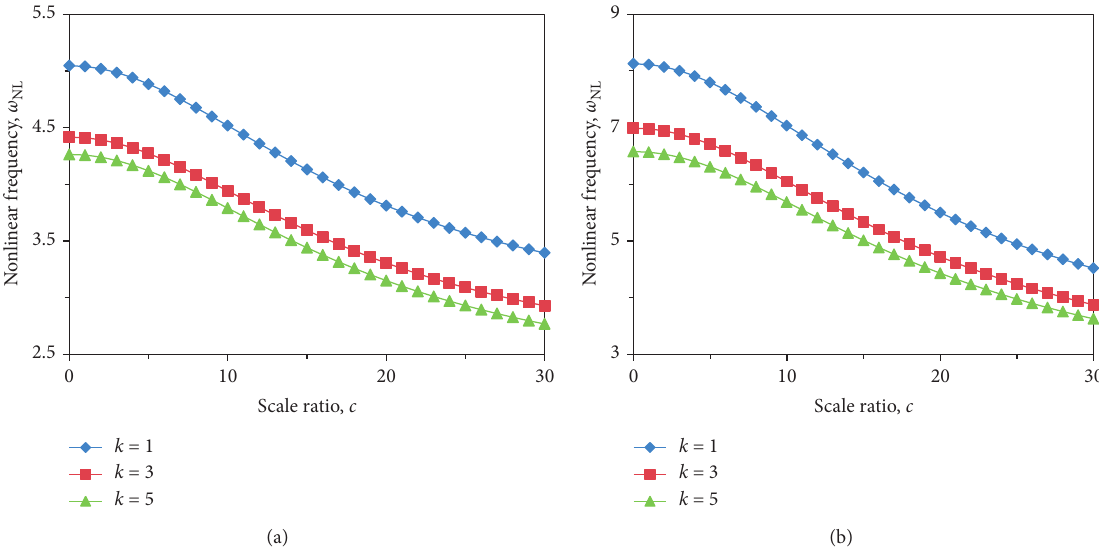
Figure 10: The variation of the nonlinear frequencies of the FG nanobeams to the scale ratio for β � 0 . 02, L / h � 20, and V without thickness effect; (b) with thickness effect.